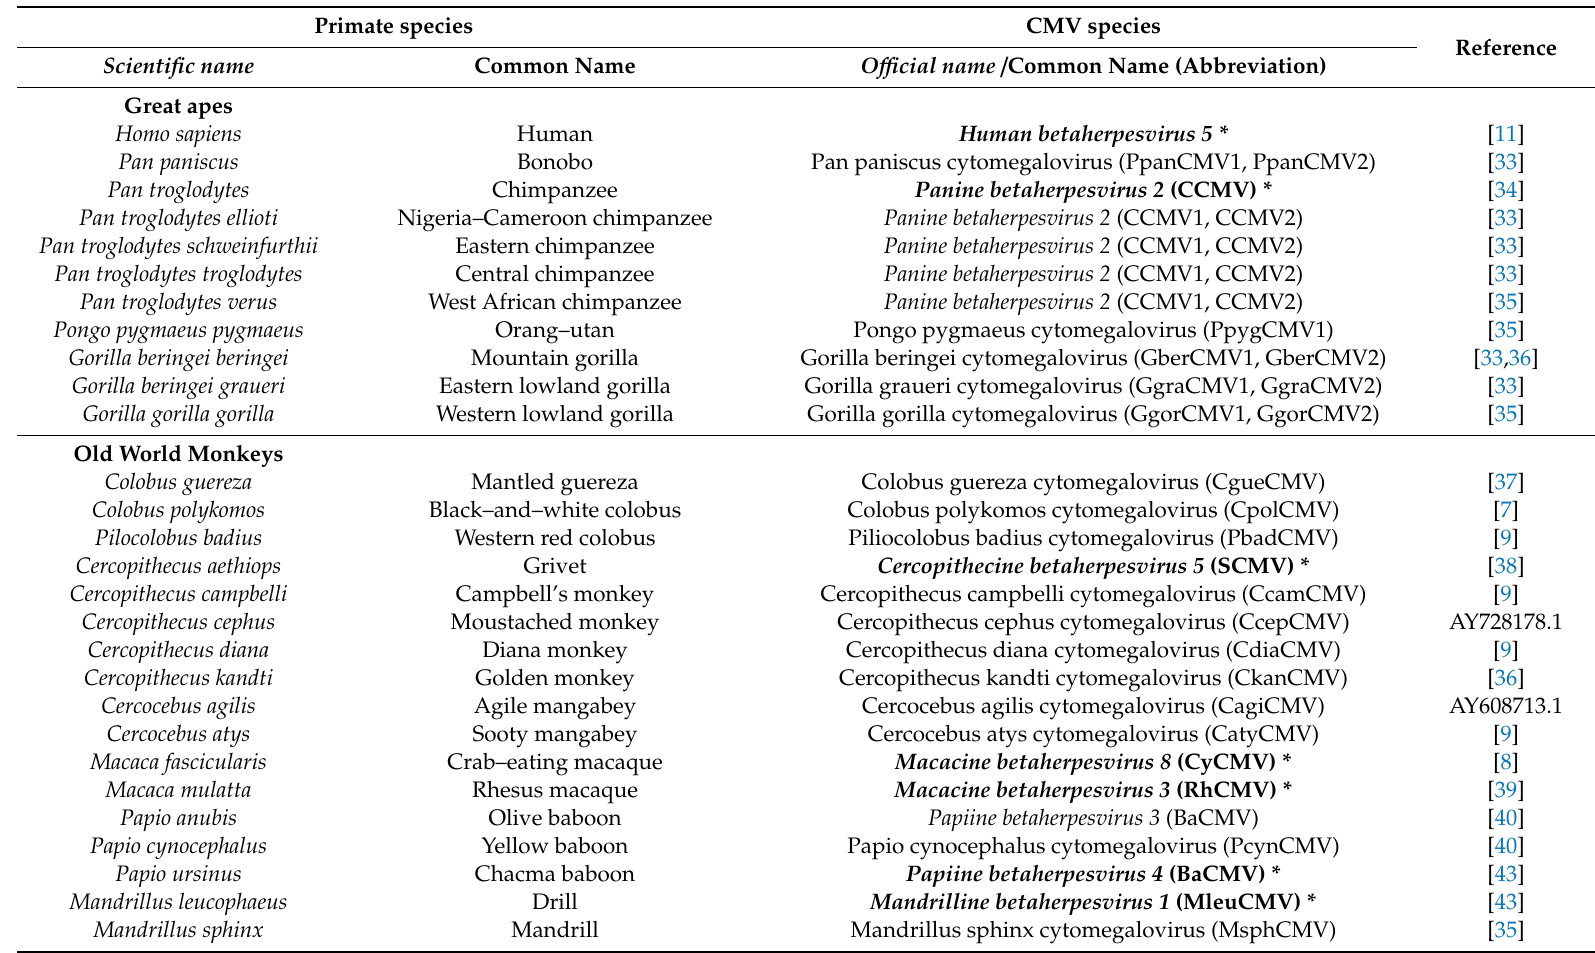
Table 1. List of known primate–infecting